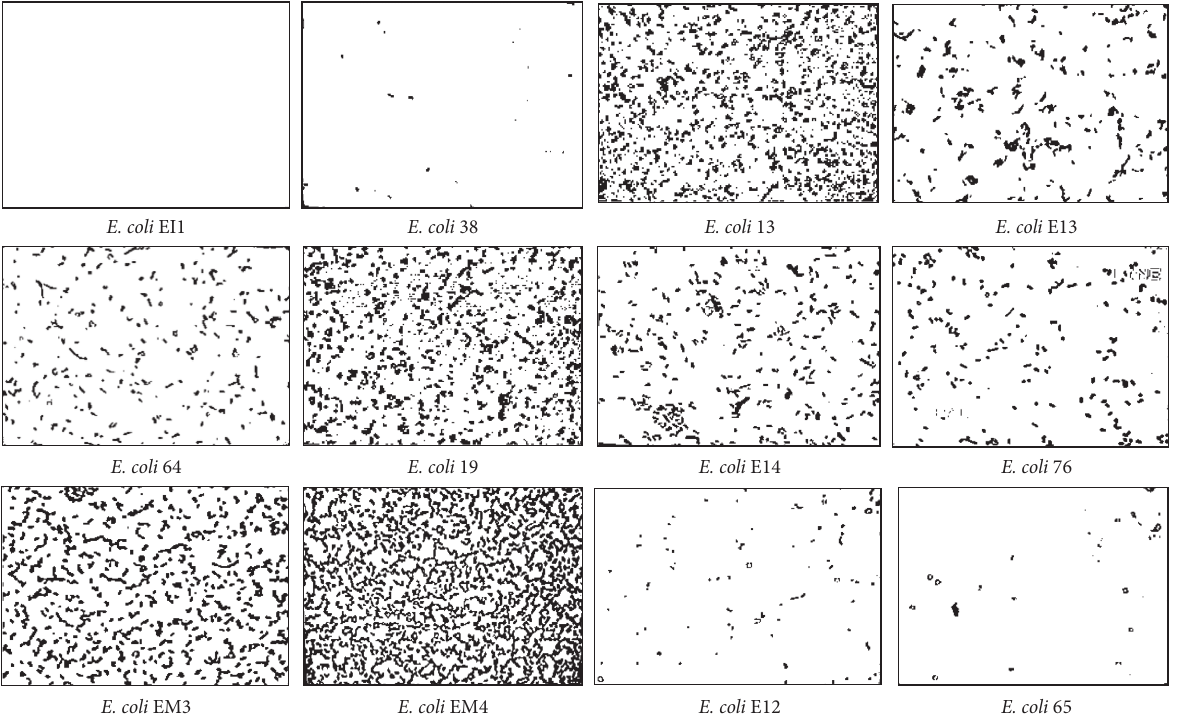
Figure 1: Microscopic images of E. coli strains adhesion to glass surface at × 400 magnification. Black spots are bacterial adhesion on glass surface.